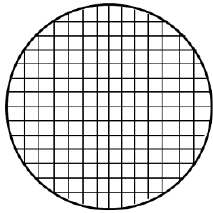
Figure 7. Cross-section of the 3D-printed gastro-floating tablets with 30% infill percentage rate [51] . Tablets with a novel design approach of caplets with perforated channels were fabri- cated by Sadia et al. to accelerate drug release from FDM 3D-printed samples (Figure 8). The experimental arrangement was to use different channel widths, lengths, and